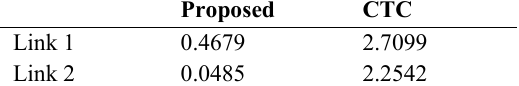
Performance of controllers for disturbance